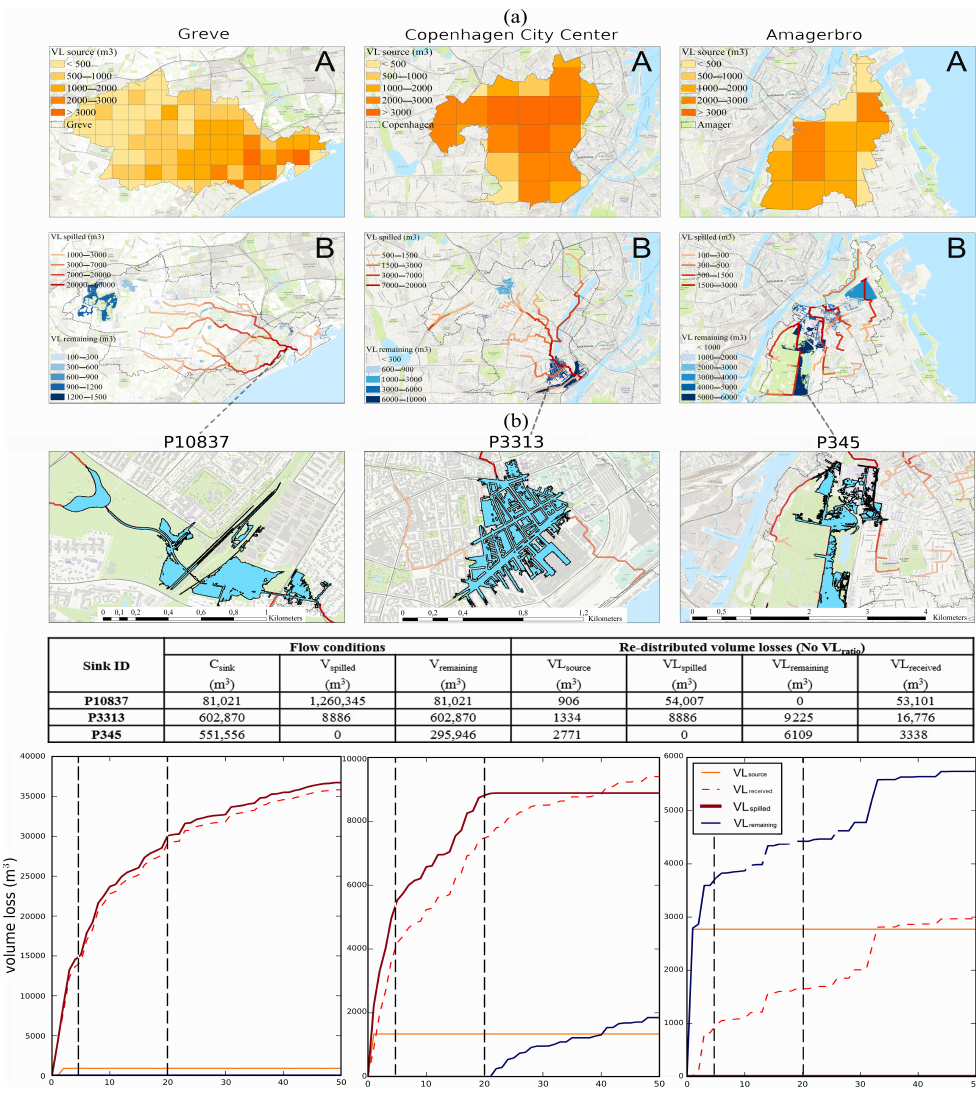
Figure 5. ( a ) Distribution and redistribution of volume losses for three case areas. A: Distribution of source volume losses. B: Re-distribution of volume losses illustrated as networks ( VL spilled ) and sinks ( VL remaining ). ( b ) Variation in volume losses of three selected sinks when using different VL ratio threshold values, demonstrated for the three case areas. Above: Location of selected sinks. Below: Curves of volume losses. The associated table represents flow conditions for the three selected sinks (P10837: Greve; P3313: Copenhagen City Center; P345: Amagerbro) and their redistributed volume losses when no VL ratio is